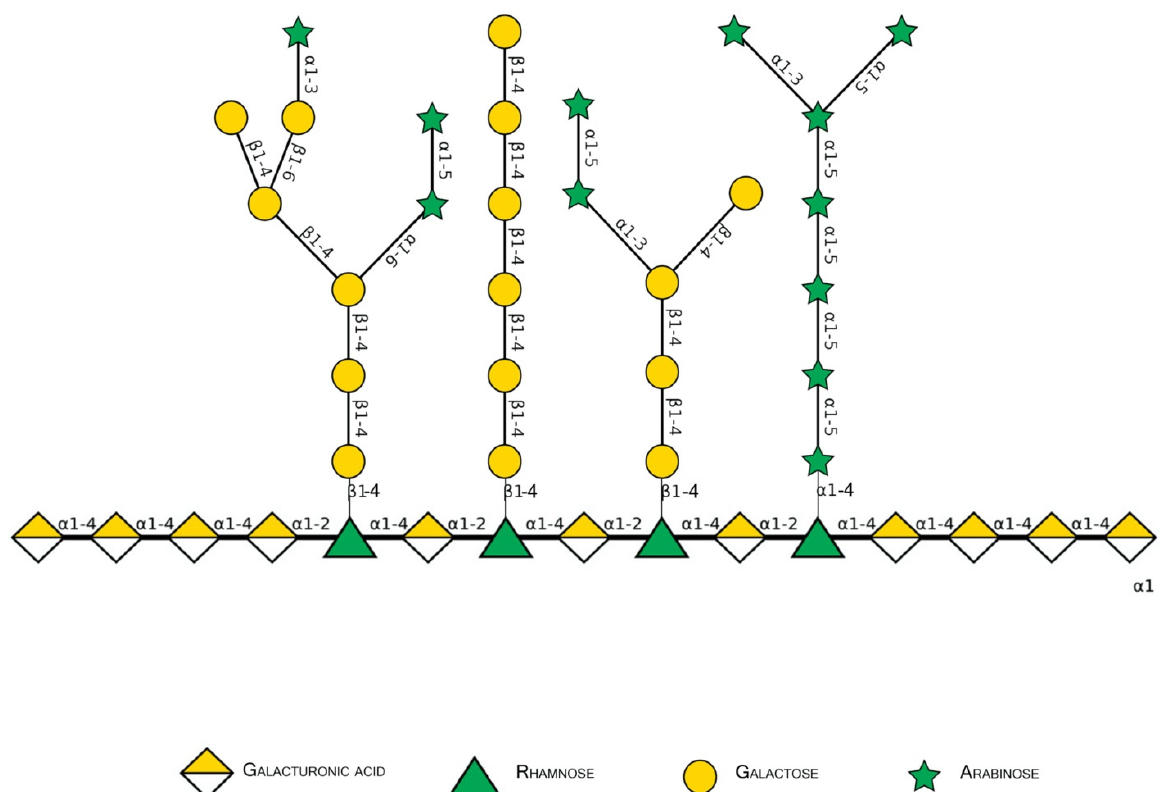
Figure 2. Schematic representation of major pectin components in Symbol Nomenclature for Glycans (SNFG-B) [9] model. Different glycosidic bounds common to pectins are illustrated.